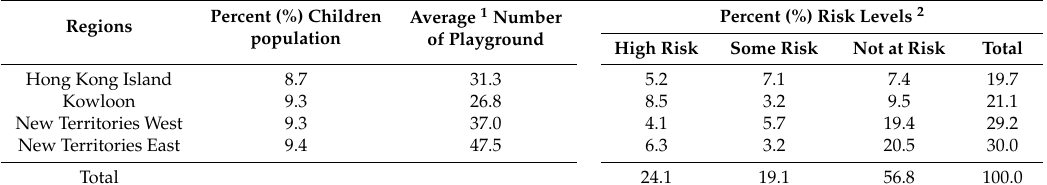
Table 4. Population distribution and risk levels of playgrounds by four regions of Hong Kong, 2016. Percent (%) Children Percent (%) Risk Levels 2 Average 1 Number Regions population of Playground High Risk Some Risk Hong Kong Island